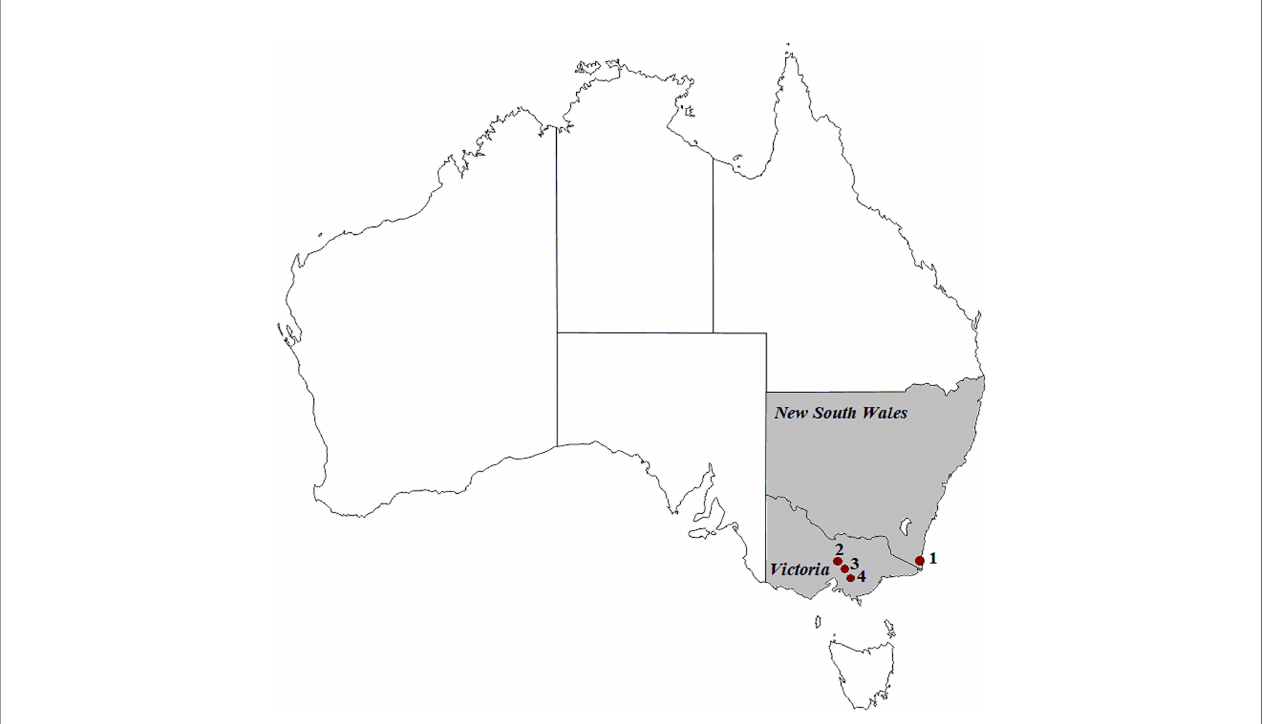
FIGURE 1 | Geographic locations of deer (1 to 4) and cattle (1, 2 and 4) sample collection in south-eastern Australia. (1) Kiah, (2) Outer Melbourne, (3) Yellingbo, (4) Bunyip. ©